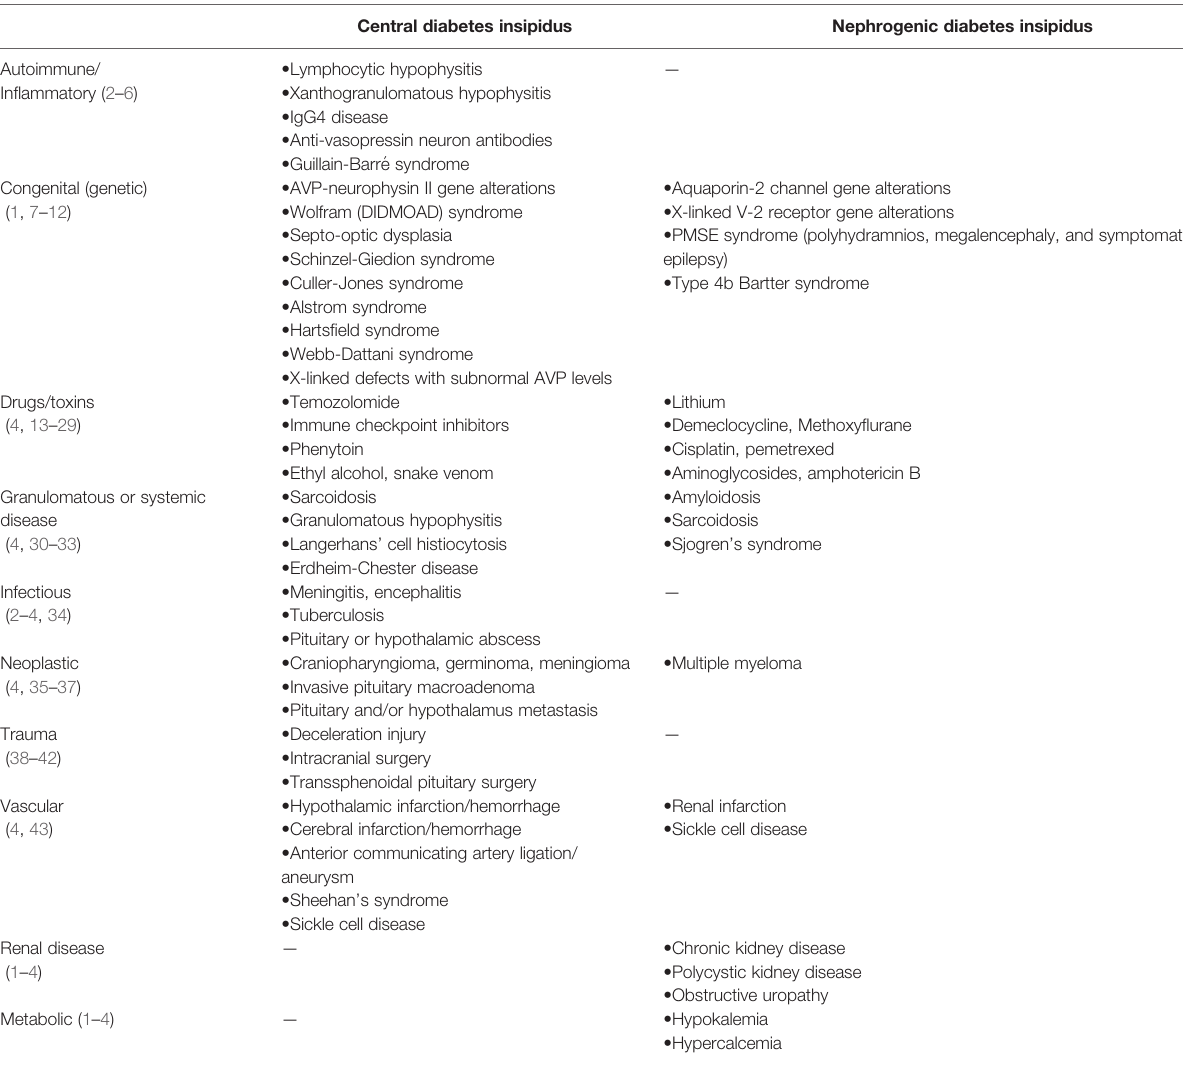
Central diabetes